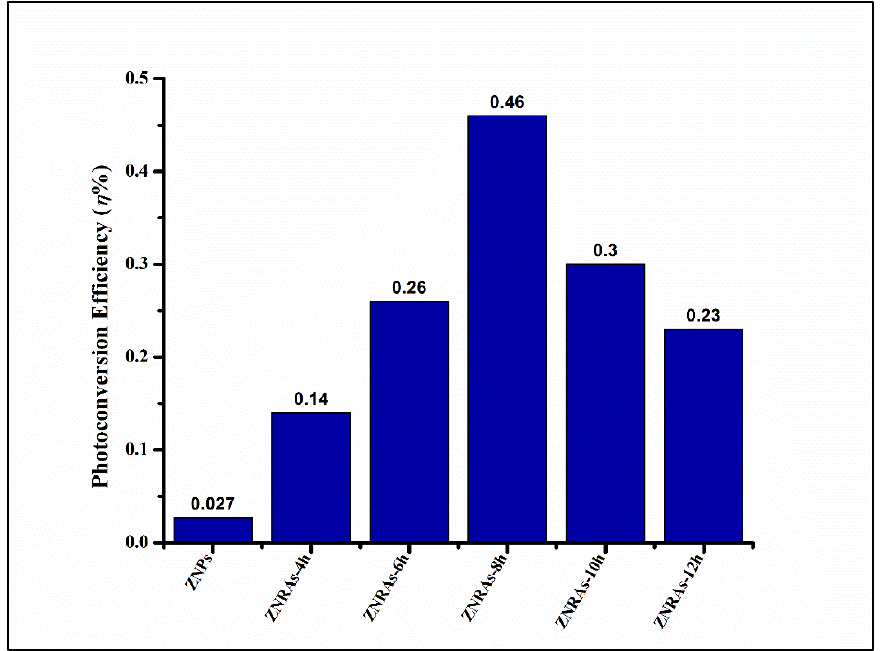
Figure 12. Values of η % for ZNPs and ZNRAs obtained at various hydrothermal growth times.